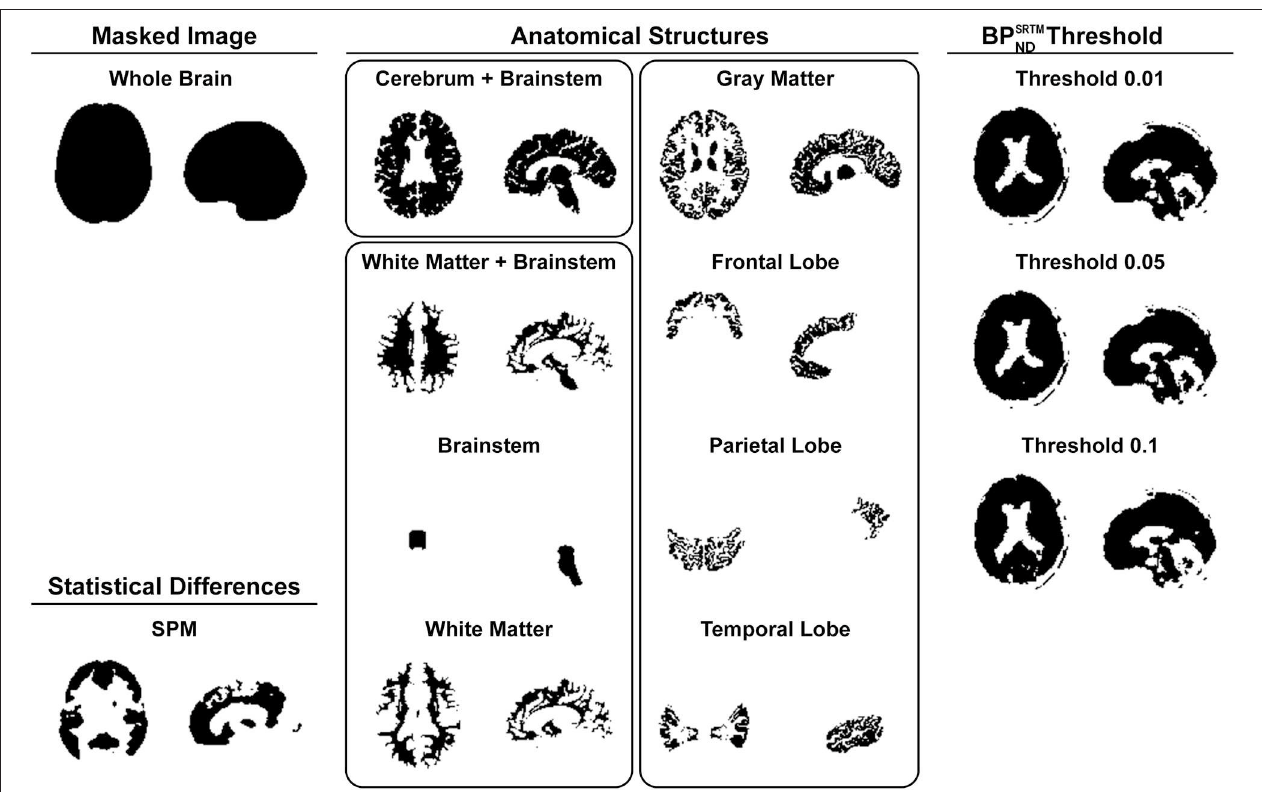
FIGURE 1 | Resemblance of the generated VOIs to be used on the estimation of k ′ 2 organized by approaches: a VOI for the whole masked image, eight volumes based on anatomical structures (Cerebrum + Brainstem, White Matter + Brainstem, Brainstem, White Matter, Gray Matter, Frontal Lobe, Parietal Lobe, and Temporal Lobe), three volumes based on different BP SRTM ND thresholds (Threshold 0.01, Threshold 0.05, Threshold 0.1), and one volume based on the statistical differences between groups on a voxel